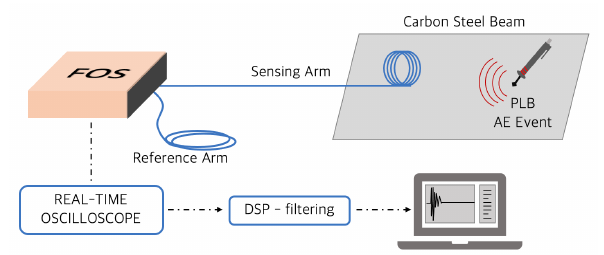
Figure 4. Experimental layout of the FOS